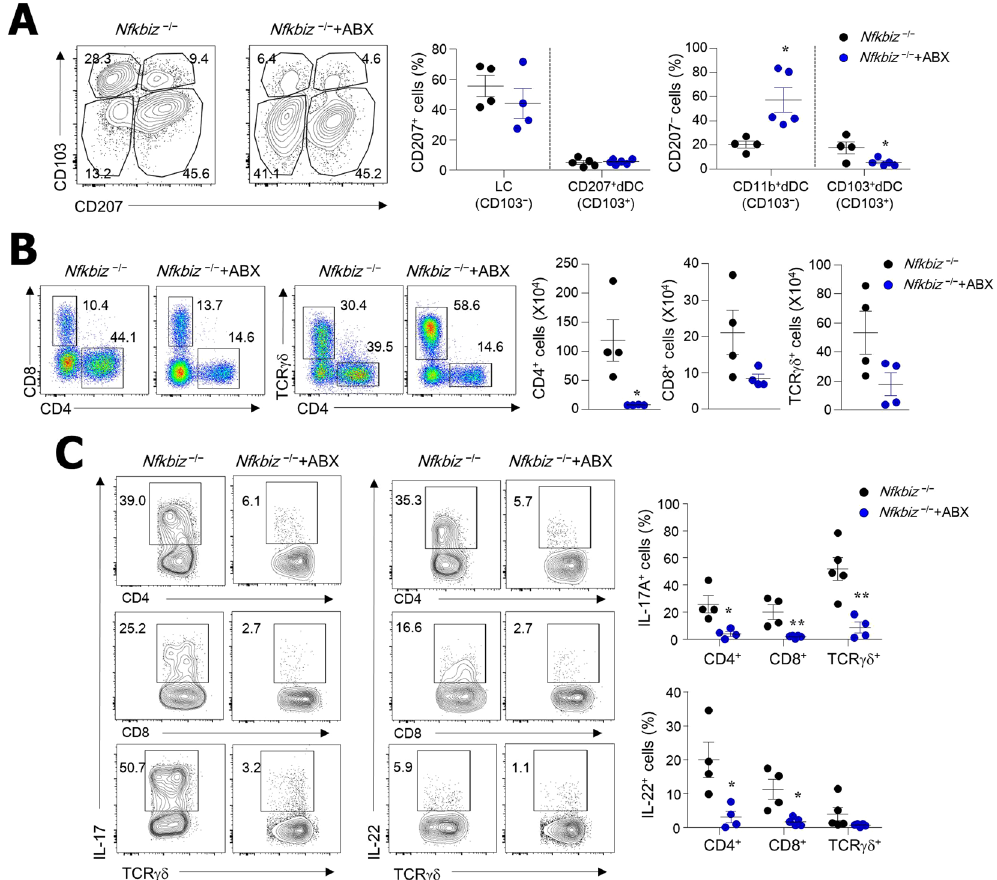
treatment. Flow cytometry analysis of ( A ) DCs in CD45 + MHCII + CD11c + cells and ( B ) T cells in CD45 + cells isolated from skin of water- and ABX-treated Nfkbiz − / − mice at age 6 weeks. ( C ) IL-17A and IL-22 production by CD45 + cells in skin. Data are representative of three independent experiments. * p < 0.05, ** p <